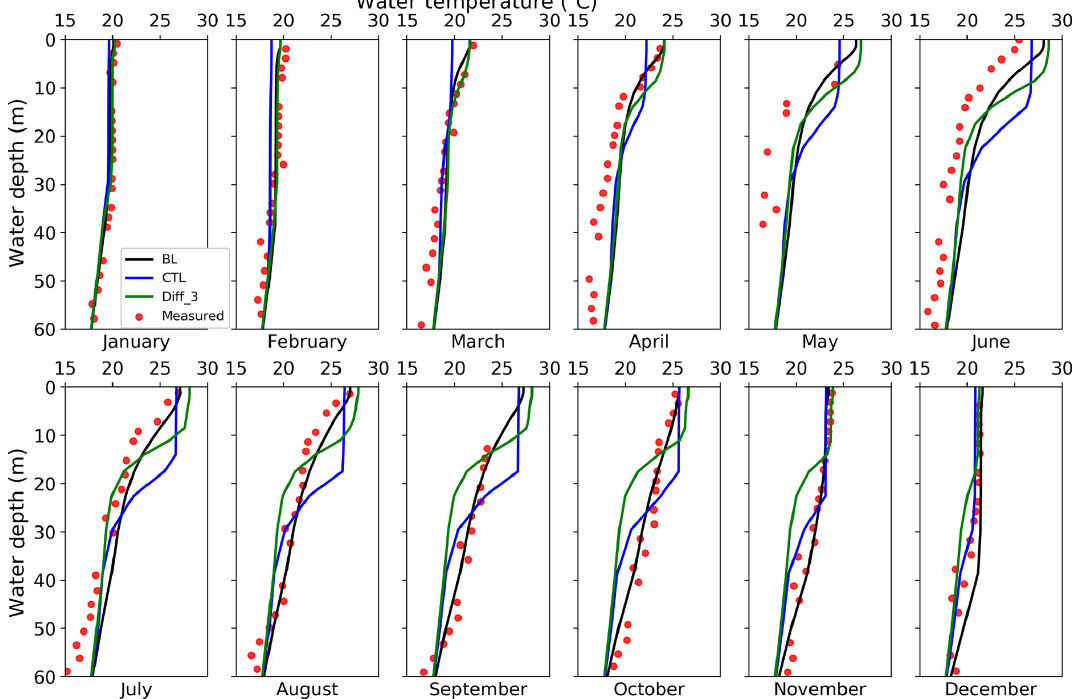
Figure 6. Monthly vertical temperature profiles for the first 60m water in the year 2015 by observation (red dots), BL (black line), CTL (blue line), and Diff_3 (green